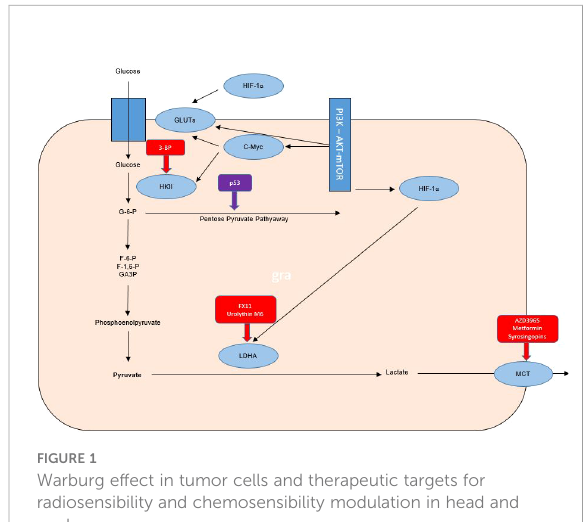
FIGURE 1 Warburg effect in tumor cells and therapeutic targets for radiosensibility and chemosensibility modulation in head and neck